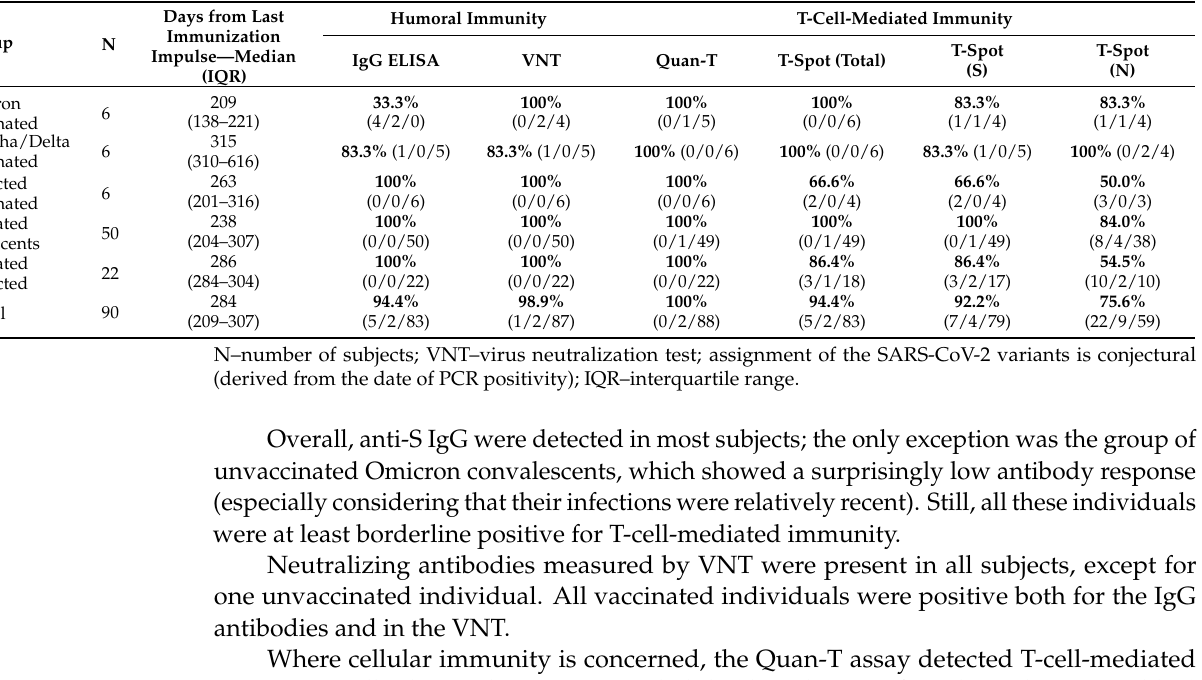
Table 3. Subgroup analysis according to the infection variant; results of tests are presented as % positive (negative/borderline positive/positive); the borderline positives are considered positive for the purposes of the calculation of the overall